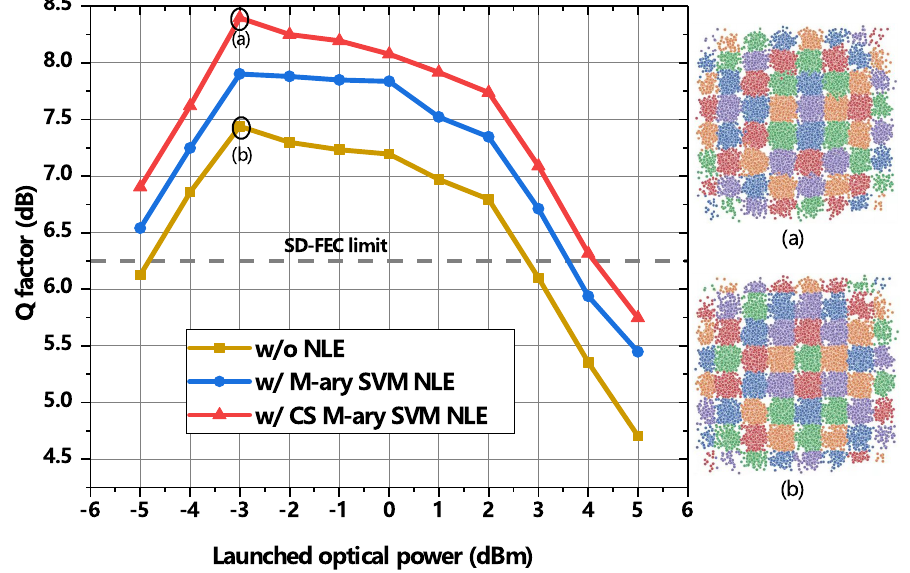
Figure 10. Q factor versus launched optical power for 120 Gb/s PS-64QAM coherent optical commu- nication system with a transmission distance of 375 km; ( a ) the constellation diagram of PS-64QAM detected by CS M-ary SVM NLE; ( b ) the constellation diagram of PS-64QAM without employing